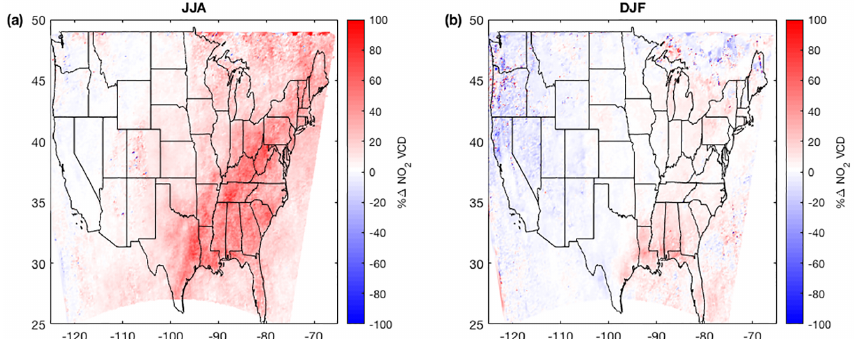
Figure 4. (a, b) Percent difference in v3.0A NO 2 VCDs using daily instead of monthly profiles averaged over (a) June–August and (b) Jan- uary, February, and December 2012. Averages exclude pixels affected by the row anomaly and with cloud fraction > 0 .